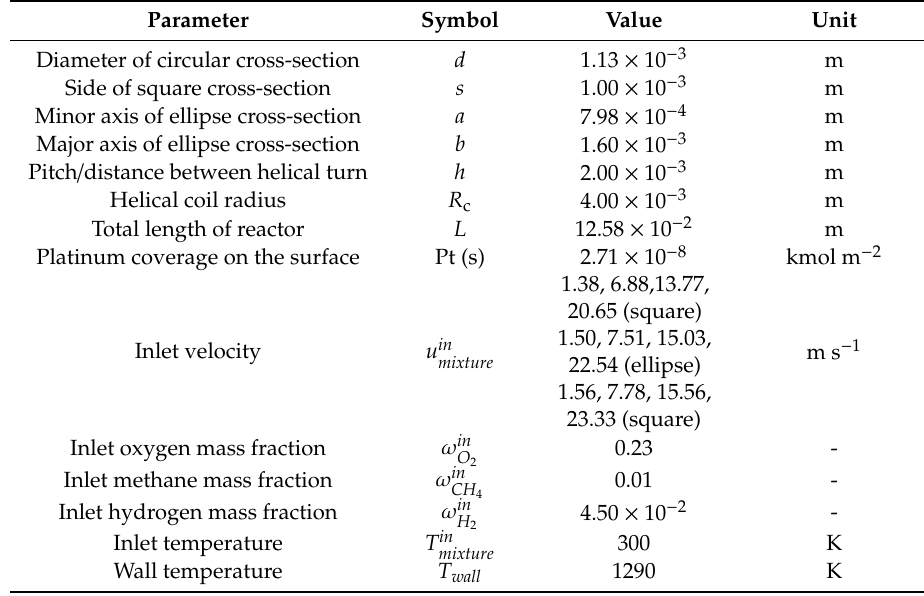
Table 1. Geometric parameters, operating parameters, and material properties.